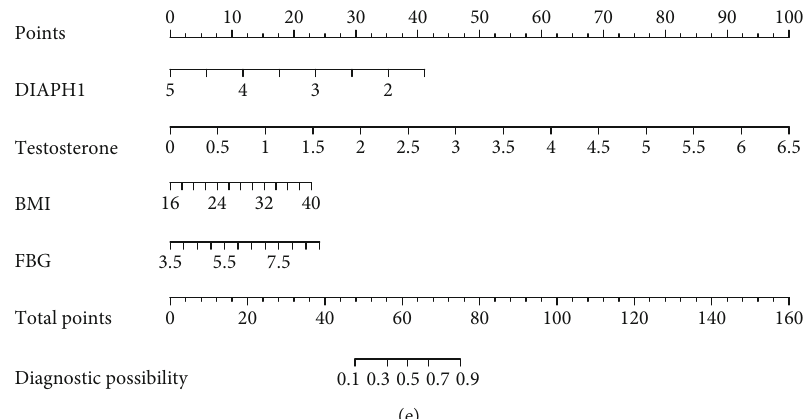
Figure 3: The diagnosis of PCOS using clinical indicators and plasma DIAPH1. (a) – (c) The ROC curves in 3 di ff erent models. (a) Model A: BMI + HOMA − β + testosterone + DIAPH1 ; (b) model B: BMI + FBG + LH/FSH + DIAPH1 ; (c): model C: BMI + FBG + testosterone + DIAPH1 . (d) The combination of ROC curves in 3 models. (e) The logistic regression-based nomogram is based on variables in model